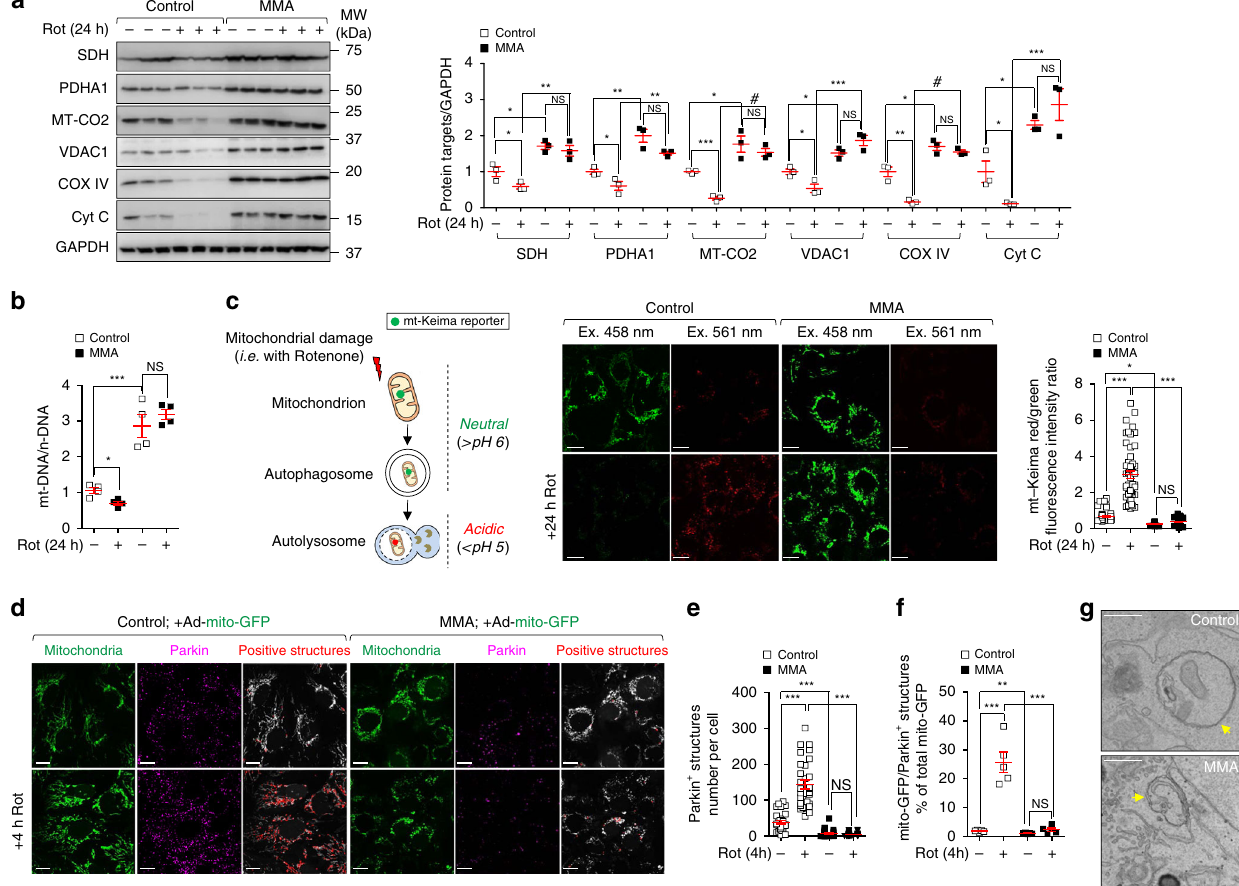
Fig. 5 Impaired mitophagy-mediated degradation of MMA diseased mitochondria. a – f Cells were exposed to Rotenone (5 μ M) for the indicated time. a Immunoblotting and quanti fi cation of indicated mitochondrial proteins; n = 3 biologically independent experiments. GAPDH was used as a loading control. b The ratio between mitochondrial ( ND1 ) and nuclear DNA ( ACTB ) was determined by quantitative PCR; n = 4 biologically independent experiments. c Work fl ow of the strategy used to monitor the cellular delivery of damaged mitochondria to lysosomal compartments. Cells were transduced with adenoviral particles carrying the mitochondrially targeted form of Keima (mt-Keima) for 24h. Representative images and quanti fi cation of ratio between red and green fl uorescence intensities, with each point representing the average red/green fl uorescence intensity ratio in a cell; n = 46 untreated control cells and n = 52 Rotenone-treated control cells, and n = 51 untreated MMA cells and n = 53 Rotenone-treated MMA cells. d ‒ f Cells were transduced with adenoviral particles bearing the mitochondrially targeted green fl uorescent protein (Ad-mito-GFP). After 24h post-transduction, the cells were exposed to Rotenone for 4 h, immunostained for Parkin (magenta) and analysed by confocal microscopy. d Representative images and quanti fi cation of number of ( e ) Parkin + and ( f ) GFP/ Parkin + structures. Number of Parkin + structures per cell: n = 30 untreated and Rotenone-treated control cells, n = 39 untreated MMA cells and n = 52 Rotenone-treated MMA cells. Number of GFP/Parkin + structures (expressed as the percentage of total mitochondria): n = 5 randomly selected and non- overlapping fi elds of views per each condition. Each whole- fi eld image contains at least 10 cells. The whole- fi eld images are pooled from three biologically independent experiments. g Representative electron micrographs (EM) showing the engulfment of mitochondria within EM-compatible, double membraned- autophagic vacuoles in control but not in MMA cells. Values in c and e are pooled from three biologically independent experiment. Plots represent mean ± SEM. Two-tailed Student ’ s t- test, * P < 0.05, ** P <0.01, *** P <0.001 and # P <0.0001 relative to untreated control or to Rotenone-treated control cells in a , b and f . One-way ANOVA followed by Bonferroni ’ s post hoc test, * P < 0.05 and *** P <0.001 relative to untreated control or to Rotenone-treated control cells in c and e . Scale bars are 10 μ m in c and d , and 250 nm in g . NS non-signi fi cant. Source data are provided as a Source Data fi